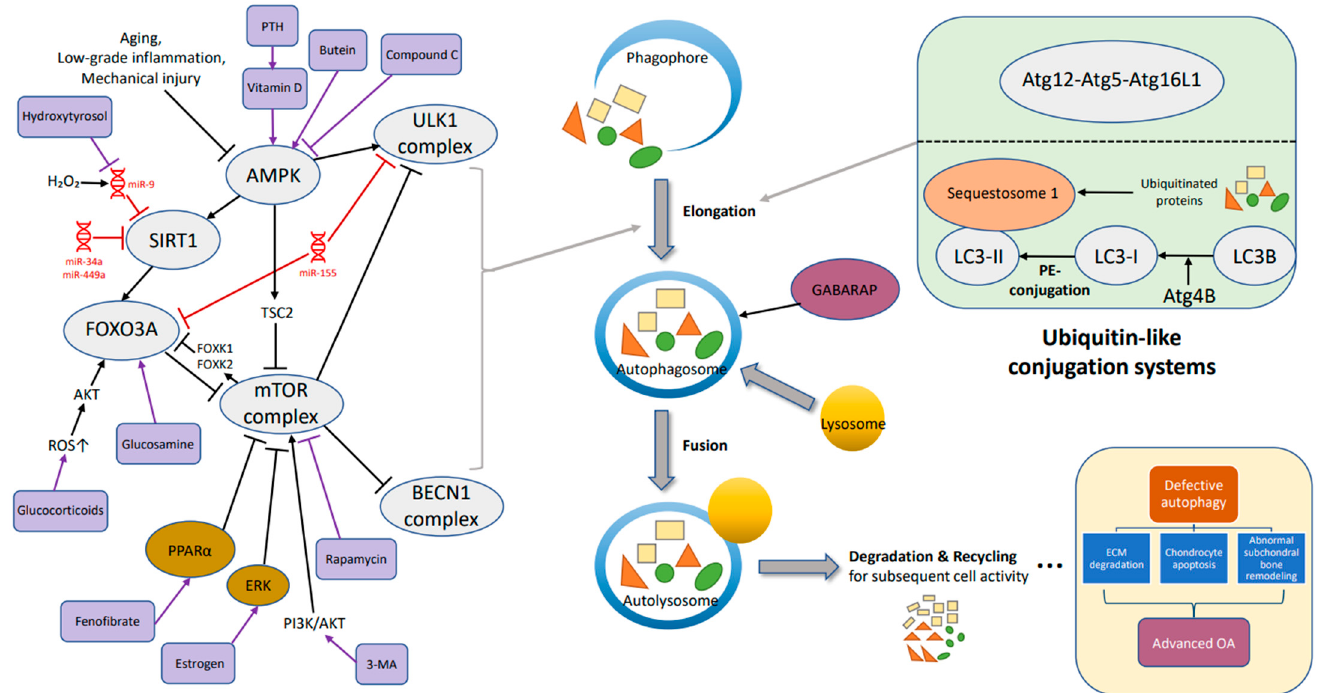
Figure 1. The mechanism of autophagy (key molecules and pathways) in osteoarthritis includes the following main steps: elongation, fusion, degradation and recycling. Defective autophagy could lead to extracellular matrix degradation, chondrocyte apoptosis and abnormal subchondral bone remodeling, resulting in osteoarthritis. → ,promote; ┤ ,inhibit.